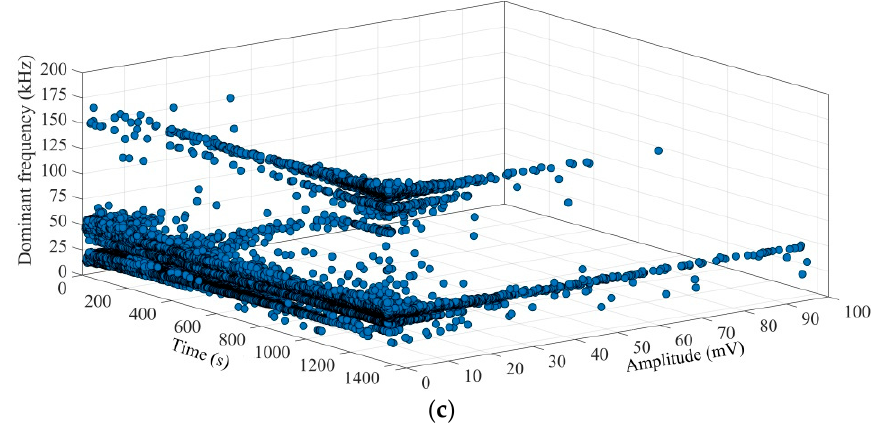
Figure 5. The 3D time-frequency plot of the dominant frequency–amplitude–time of specimens. ( a ) X-1 specimen; ( b ) X-3 specimen; ( c ) X-6 specimen.